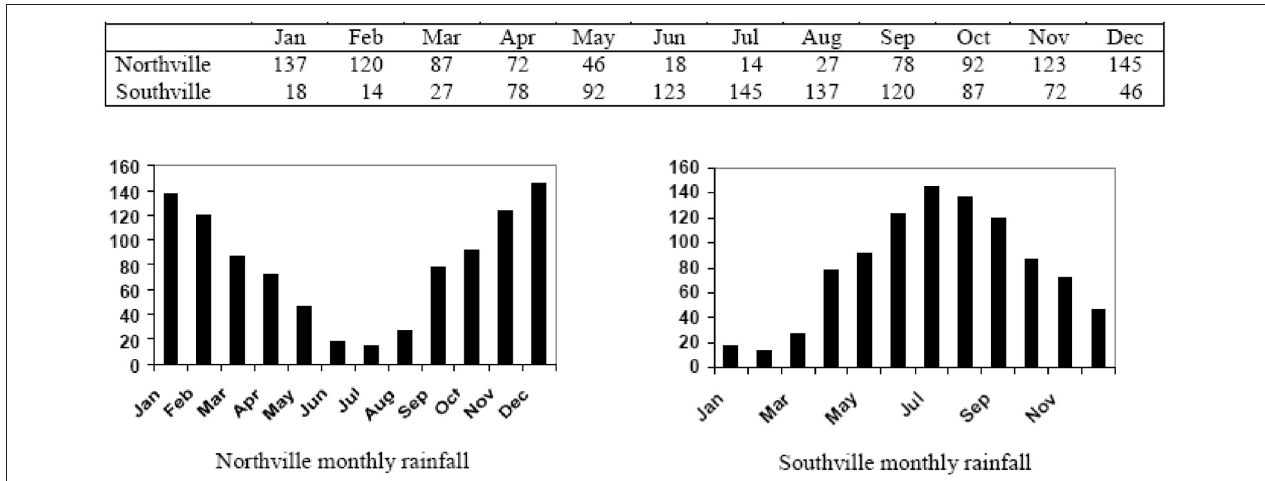
FIGURE 1 | Two hypothetical pluviographs exhibiting identical rainfall patterns (Source: http://gisweb.ciat.cgiar.org/marksim/).